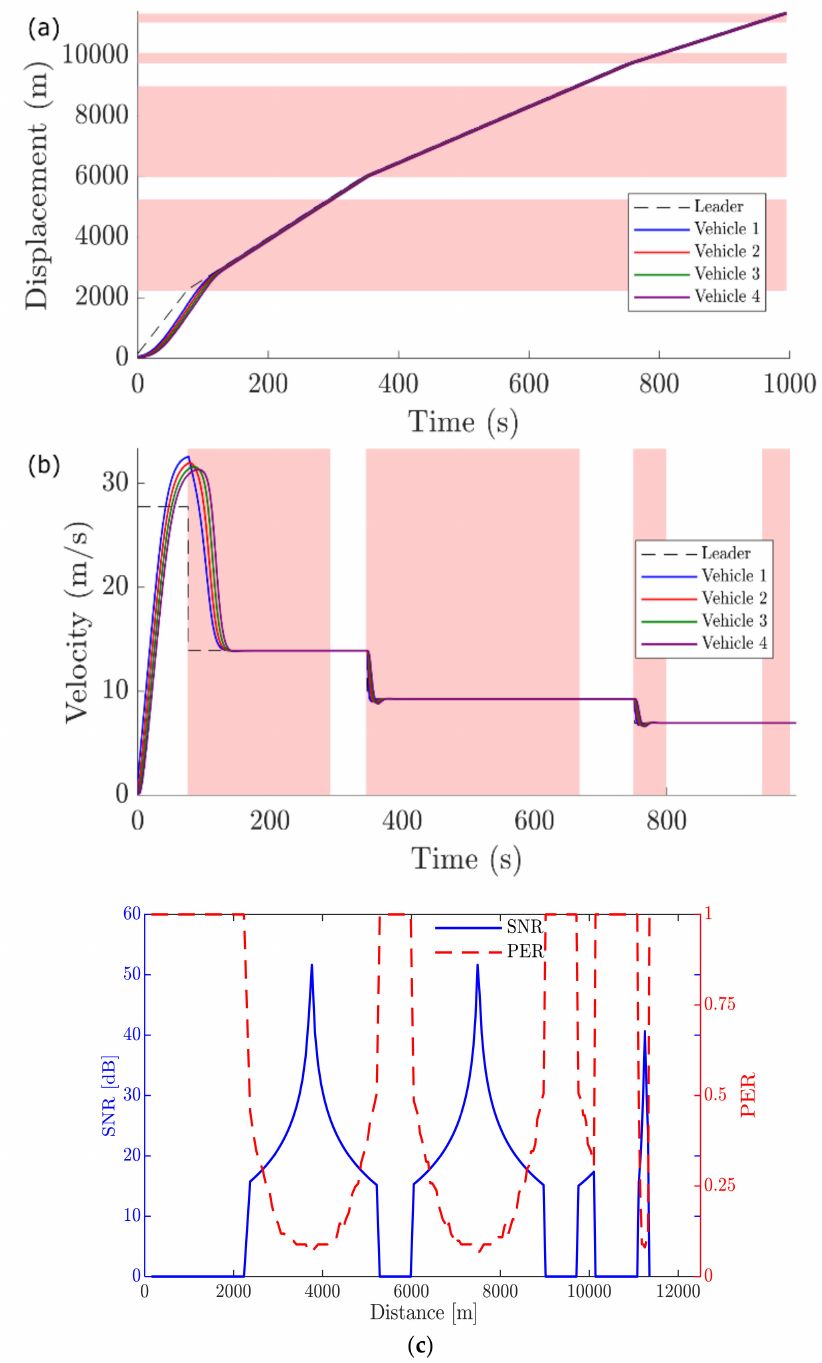
Figure 9. Case III vehicle platoon motion as described in Section 3.4: ( a ) Displacement of the vehicles over the simulation time; ( b ) Velocity of the vehicles over the simulation time; ( c ) Variation of SNR and PER as the platoon moves along the road. Leader is the platoon